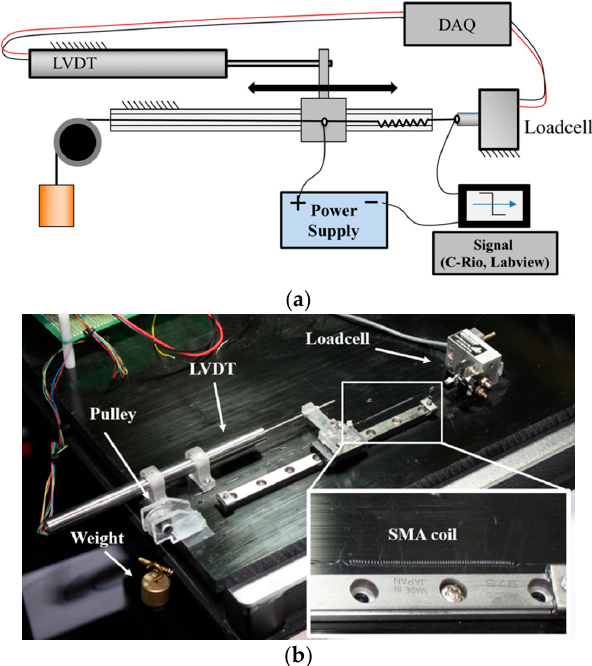
Figure 5. ( a ) Schematic diagram of the cyclic actuation experimental setup; ( b ) actual experimental setup.